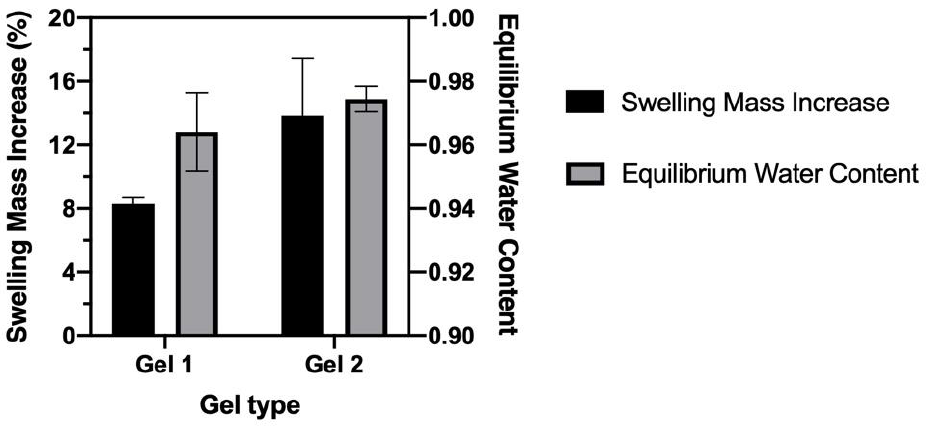
Figure 6. Swelling mass increase and equilibrium water content of CO–HA Gels ( n = 3).